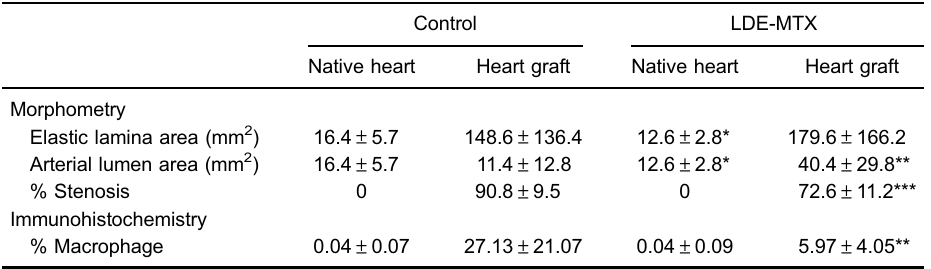
Table 2. Coronary artery measurements and percent of macrophage invasion obtained by light micros- copy morphometry and immunohistochemistry in heart grafted controls (n=10) and in heart grafted rabbits treated with lipid nanoemulsion-methotrexate (LDE-MTX) (4 mg (cid:1) kg body weight – 1 (cid:1) week – 1 during 6 weeks,